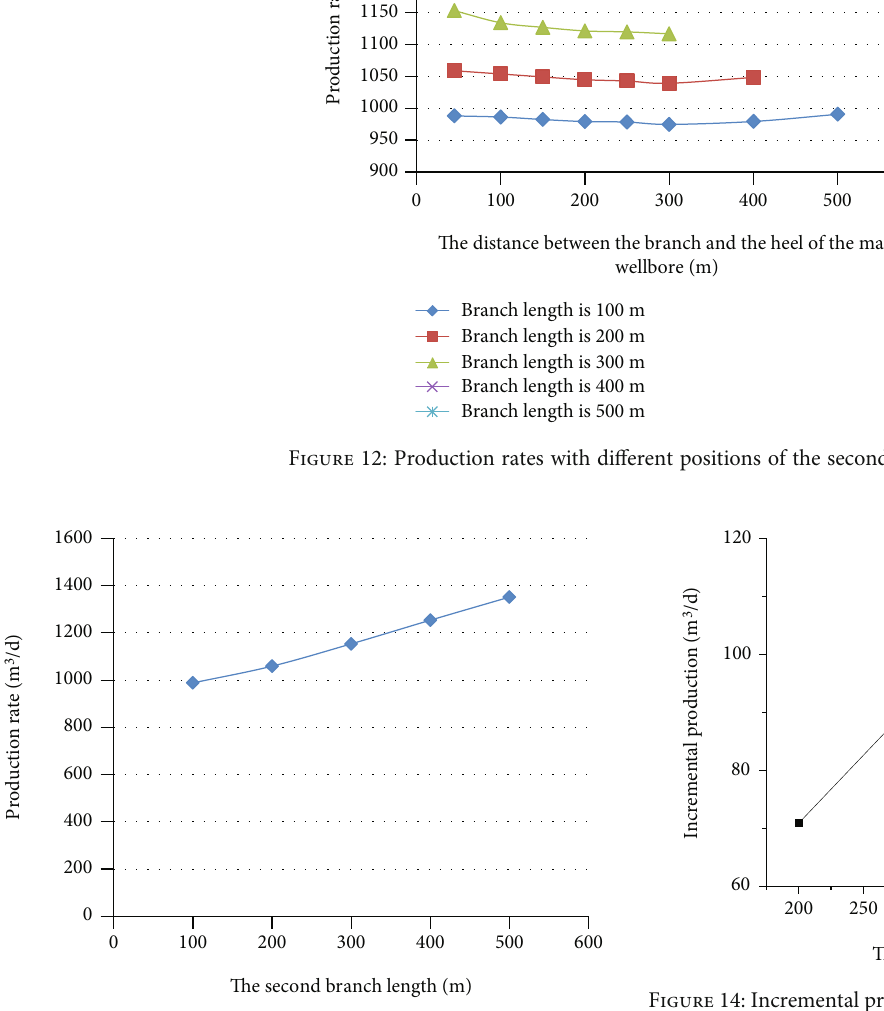
Figure 13: Production with di ff erent length conditions of the second branch.